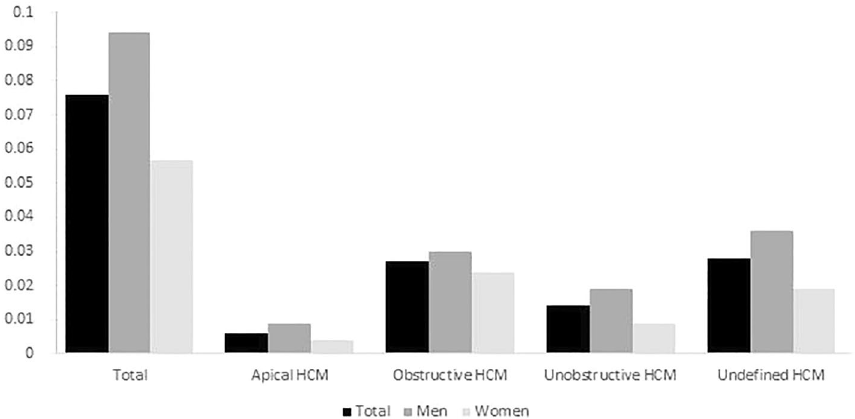
Figure 1. Prevalence of hypertrophic cardiomyopathy and its subtypes in 2019 in the total, males and females. HCM, hypertrophic myocardiopathy.